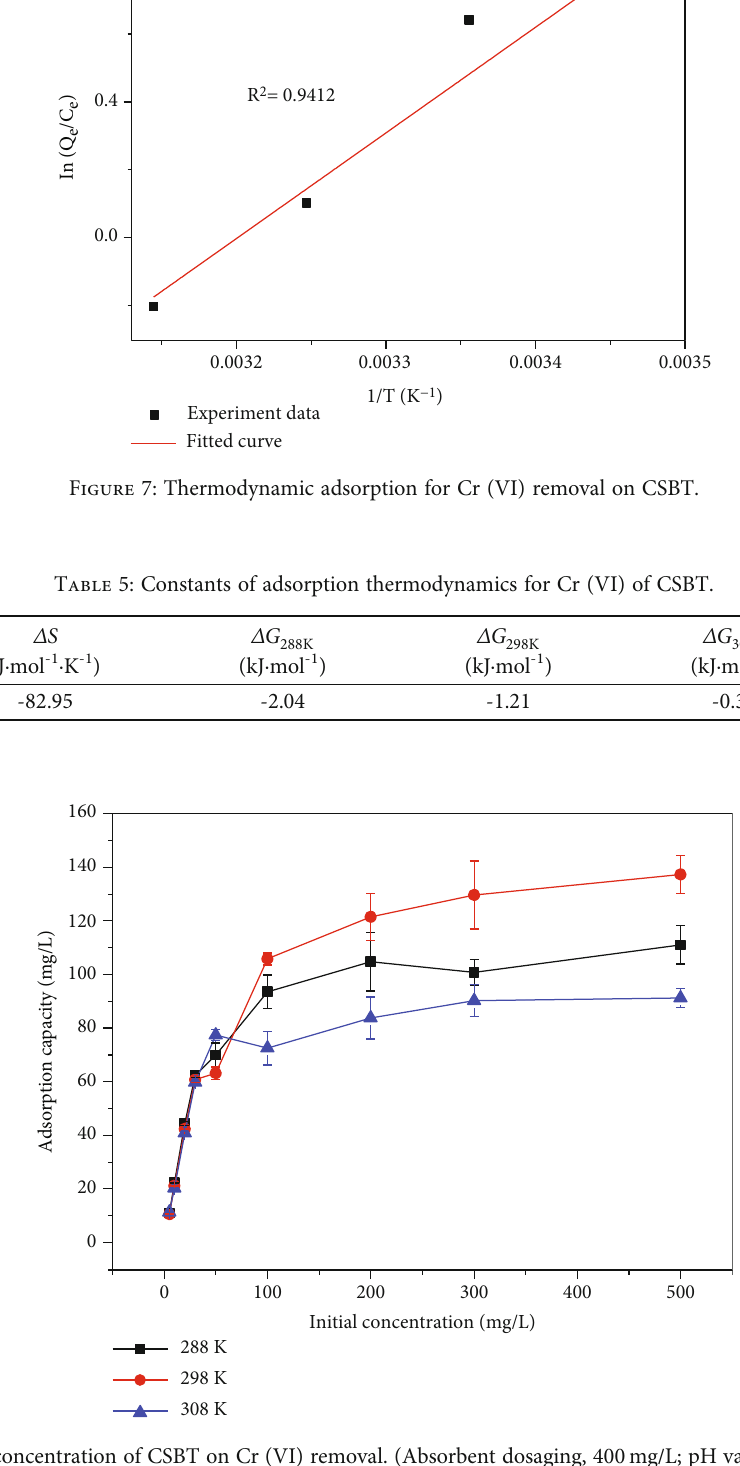
Figure 8: E ff ect of initial concentration of CSBT on Cr (VI) removal. (Absorbent dosaging, 400 mg/L; pH value, 3.0; contact time, 90 min; rpm,